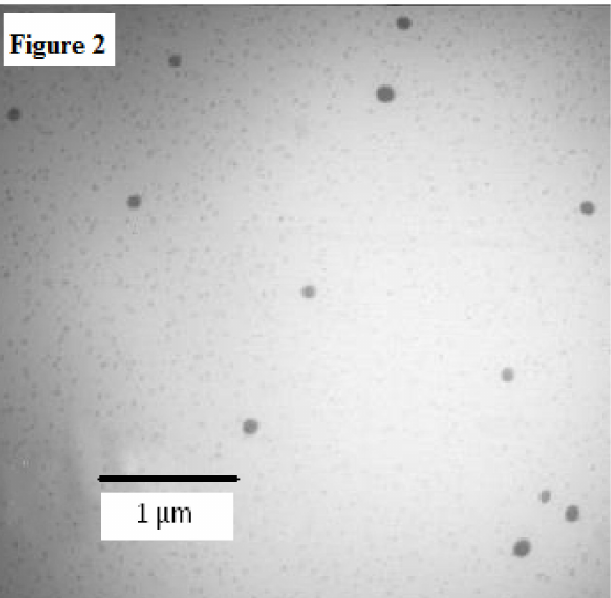
Figure 2. Transmission electron microscopy (TEM) image for an optimized formulation NEO-NE 4 . Table 4. Ex vivo permeability parameter of prepared NEs (mean ± SD, n = 3).